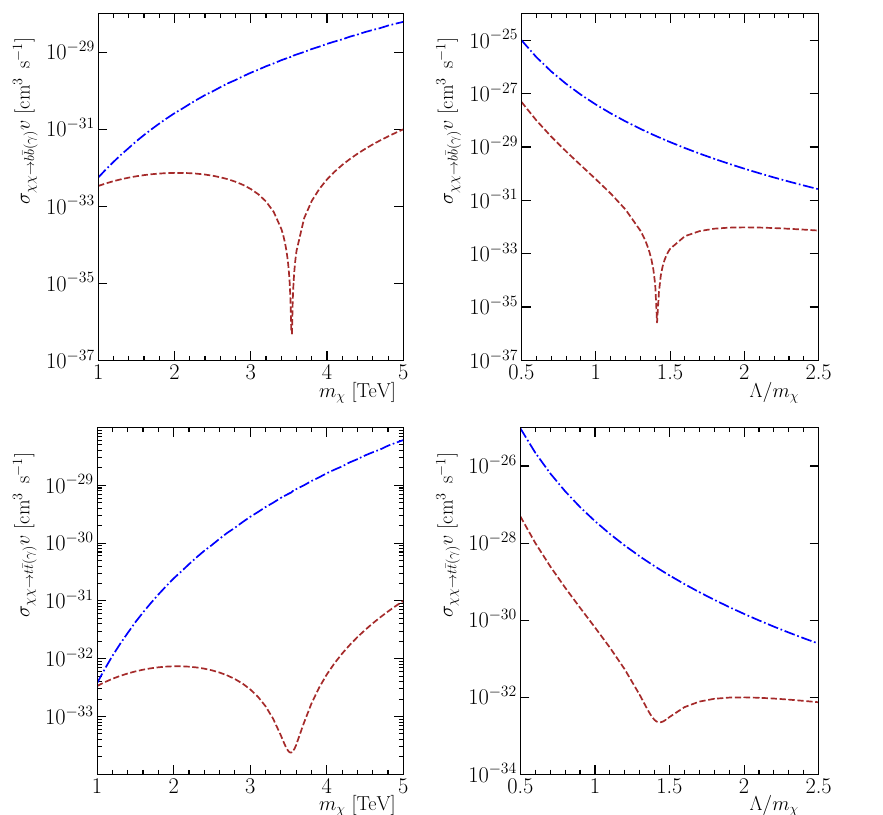
Figure 3 . ( 1 st column: ) cross sections for the 3-body and 2-body process as a function of the dark matter mass, m (cid:31) (left), and as a function of the ratio (cid:3) =m (cid:31) (right). In the left panel we set (cid:3) = 5 TeV and in the right panel m (cid:31) = 2 TeV. The 3-body cross section is denoted by the blue dash-dotted line and the brown dashed line denotes the 2-body cross section. We set d 6 = 1, d 8 = 1, and v = 10 (cid:0) 3 c for both of these plots. ( 2 nd column: ) The same for the (cid:12)nal state comprising of top